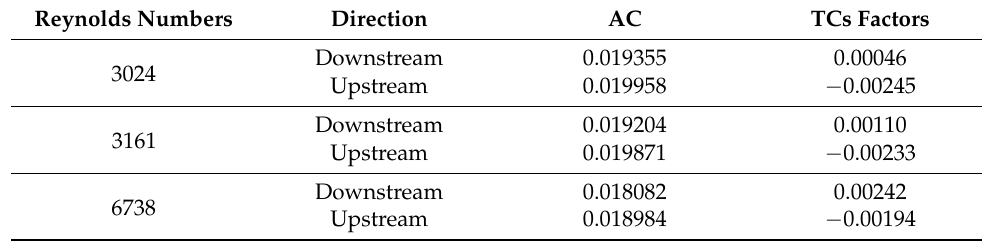
Table 10. The ACs and TCs under different Reynolds numbers.